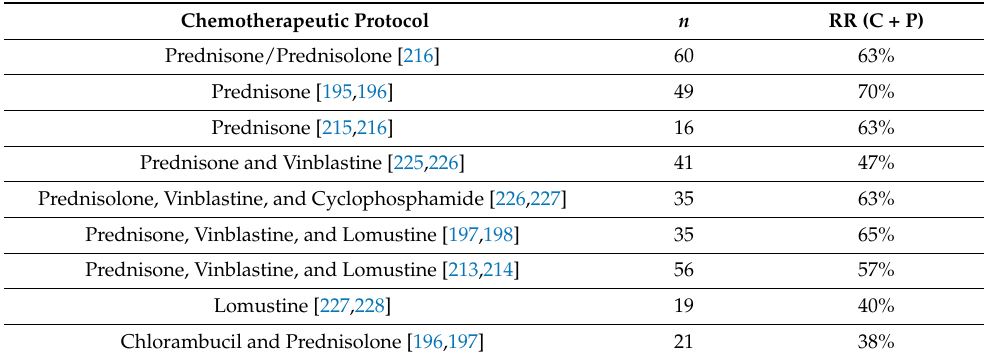
Table 6. Published Chemotherapy Protocols for Treating Advanced Mast Cell Tumors in Dogs and the Associated Remission Rates (RR) (Adapted from